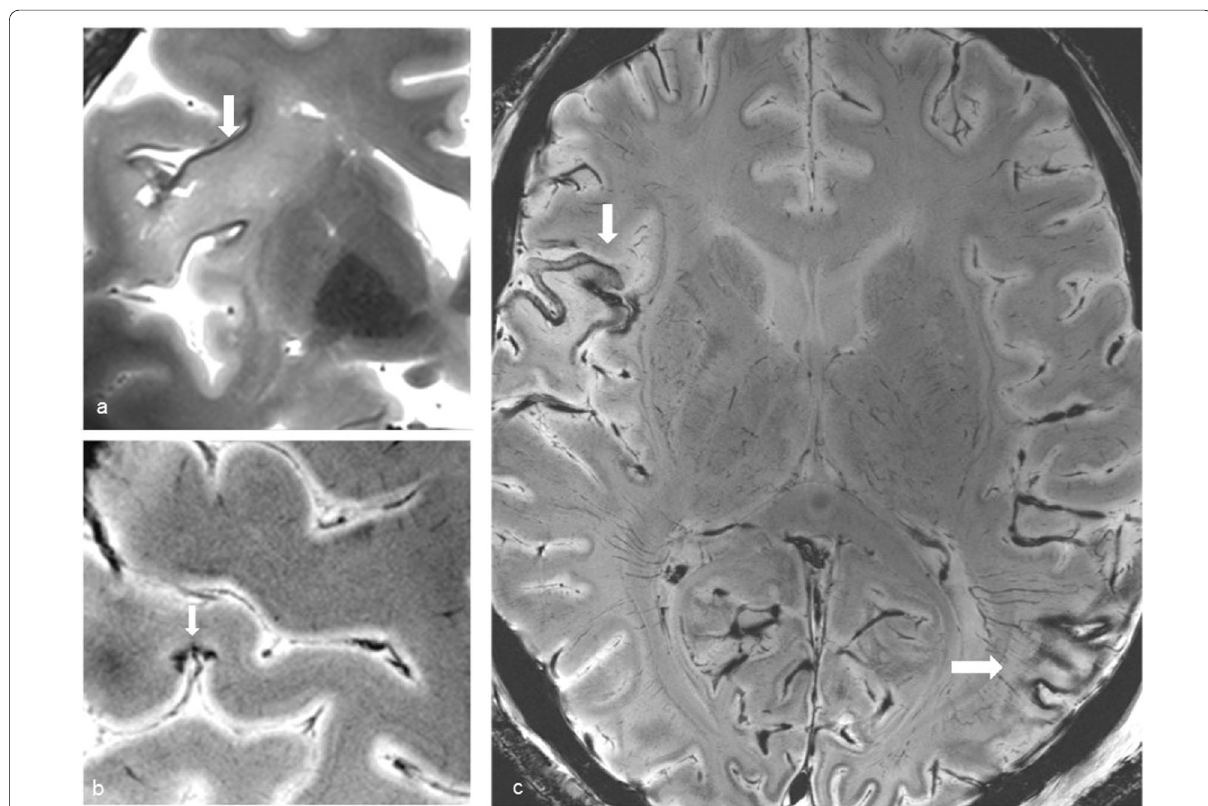
Fig. 2 Coronal T2 ( a ) and axial SWI ( b , c ) of patient 1 showing two large (right frontal and left parietal) cortical–subcortical infarcts with petechial cortical hemorrhage, and a smaller right frontal cortical infarct ( b ). Previous brain imaging unavailable, so timing of the infarct could not be established; imaging features do not indicate an acute lesion; previous heart failure could favor chronic